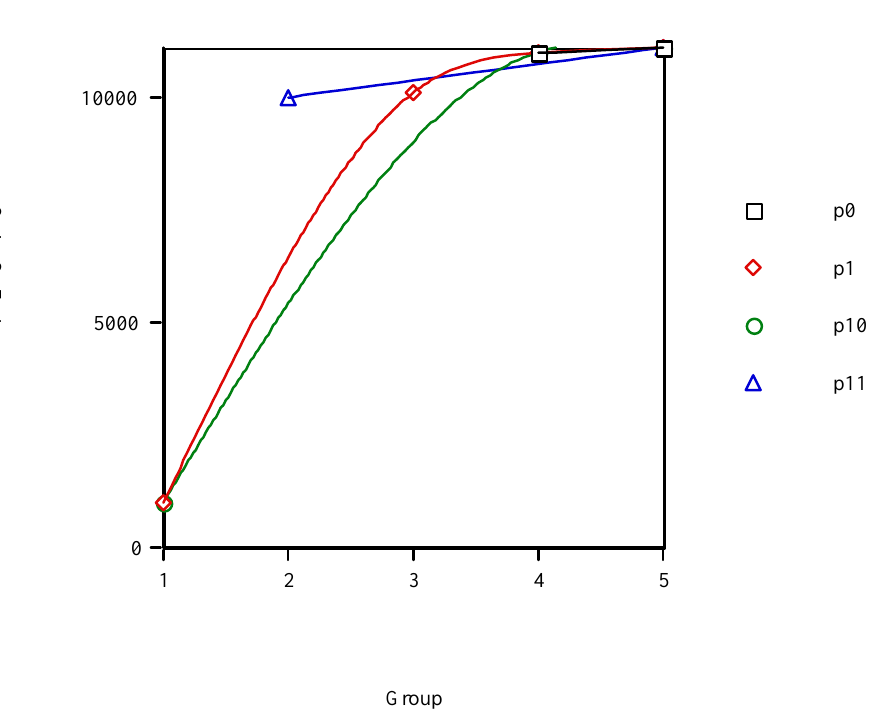
Figure 10. Variation of the vector property of local anaesthetics vs . group